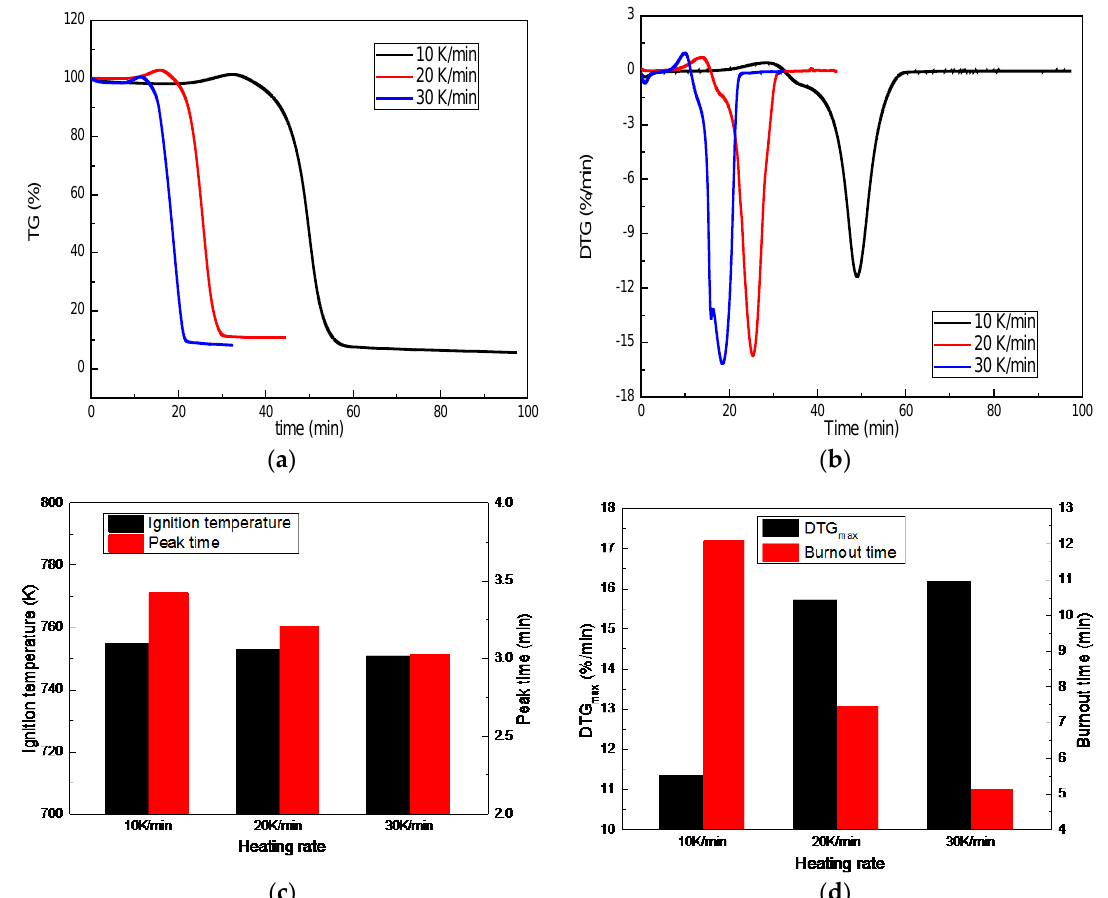
Figure 7. Effect of heating rate on coal combustion: ( a ) TG profile; ( b ) DTG profile; ( c ) and ( d ) Coal combustion characteristics.